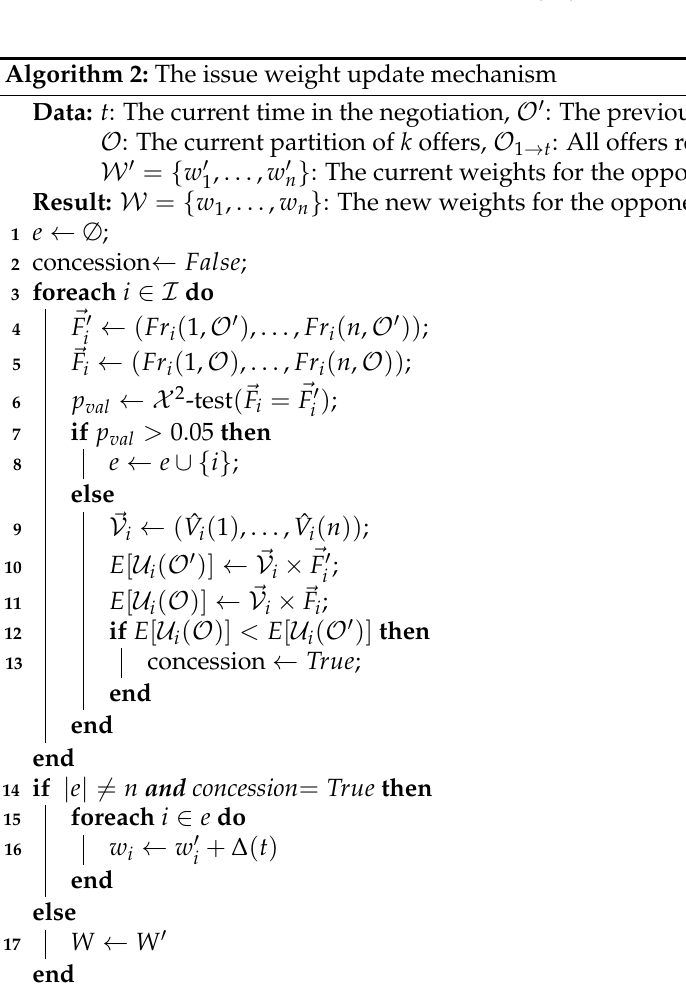
Algorithm 2: The issue weight update